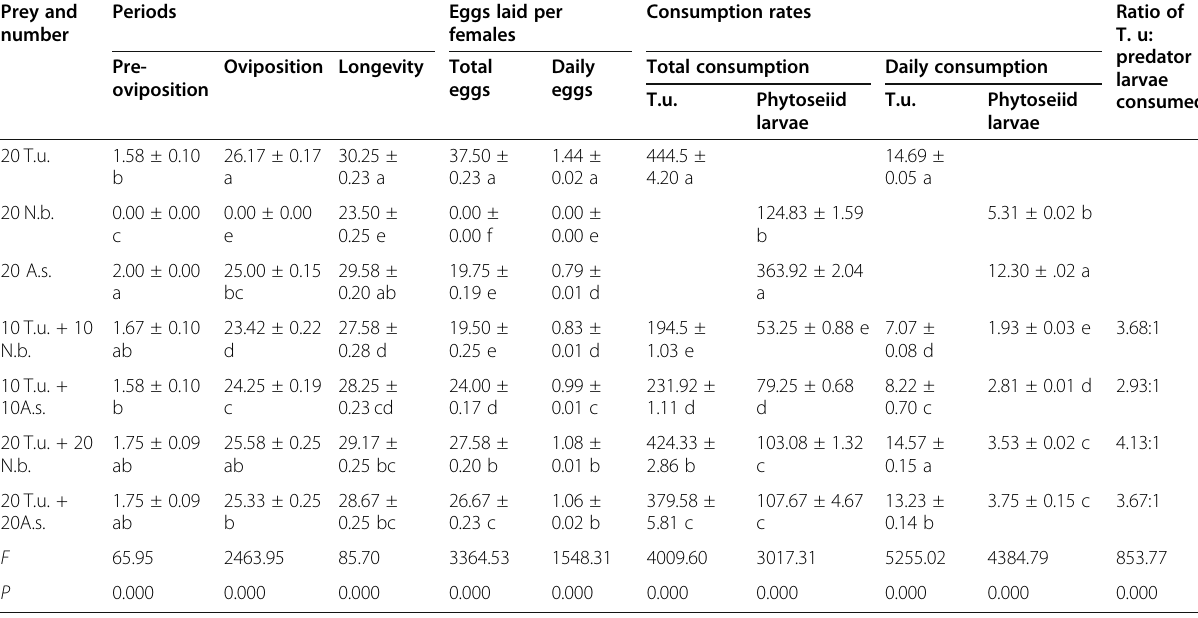
Table 1 Mean (± SE) pre-oviposition, oviposition periods and longevity, mean number (± SE) of total and daily eggs laid per female, total and daily number (± SE) of prey consumed per female for Neoseiulus californicus fed solely on Tetranychus urticae (T.u.) or larval Neoseiulus barkeri (N.b.), Amblyseius swirskii (A.S.) or on a combination of T. urticae and larval phytoseiid Prey and Periods Eggs laid per Consumption rates Ratio of number females T. u: